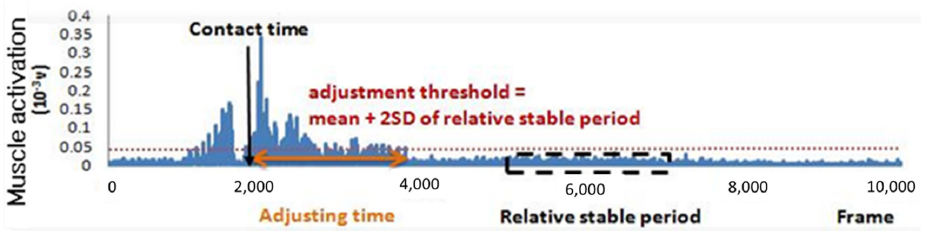
Figure 3. Calculation of adjusting time parameter in landing test (an example of ankle dorsiflexors).